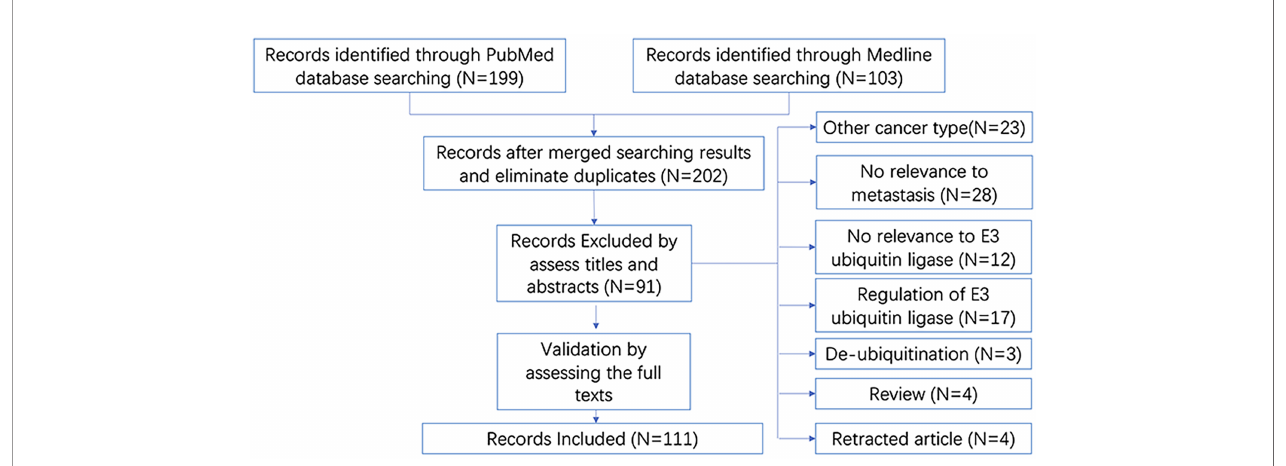
FIGURE 3 | Brief fl ow chart for literatures searching and selection. “ N ” refers to “ number of studies